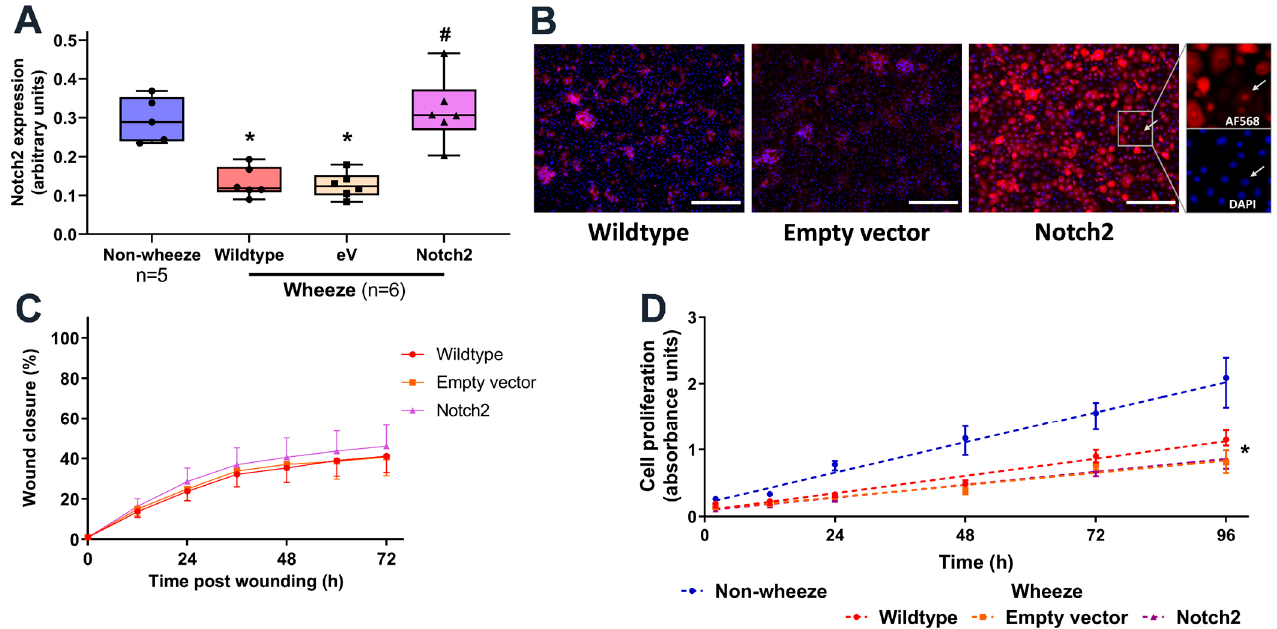
Figure 6. Overexpression of Notch2 in pAEC from children with wheeze. ( A – D ) Cultures from children with wheeze were infected with a retrovirus containing either the empty vector-GFP or Notch2-GFP. ( A ) Protein expression of Notch2 was measured by In-Cell Western and normalized to cell number. ( B ) Immunofluorescent staining for Notch2 intracellular domain protein identified its nuclear staining in Notch2-overexpressed cultures. Scale bar: 200 µ m (20 × magnification) ( C ) Monolayer pAEC cultures expressing Notch2-GFP (purple triangles) or empty vector-GFP (orange squares) and wildtype controls (red circles) displayed comparable repair capacity following in vitro scratch wounding. ( D ) Cultures from children with wheeze (red circles) showed significantly lower cell proliferation rates compared to non-wheeze controls (blue circles). Notch2 overexpression (purple triangles) had no effect on cell proliferation compared to empty vector-GFP (orange squares) or wildtype wheeze controls (red circles). Experiments utilized pAEC cultures from children with ( n = 6) and without wheeze ( n = 5). Data are represented as median ± IQR (* p < 0.050, wheeze vs. non-wheeze; # p < 0.050, empty vector/Notch2 vs. Wildtype control; Dunn’s multiple comparisons